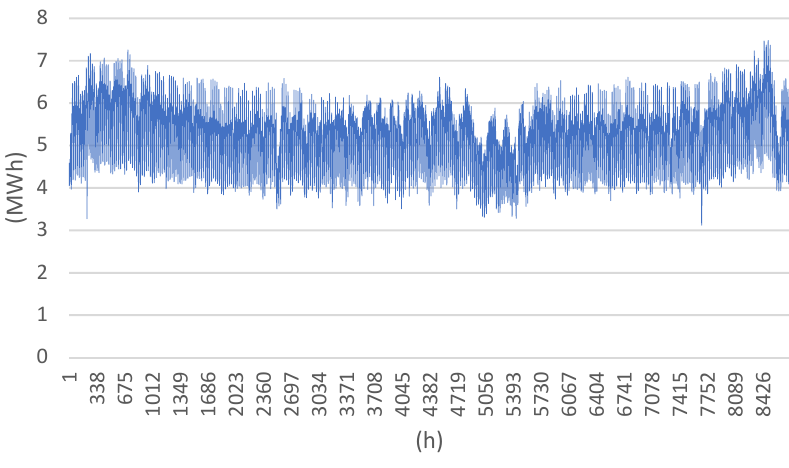
Figure 4. Annual electricity demand.